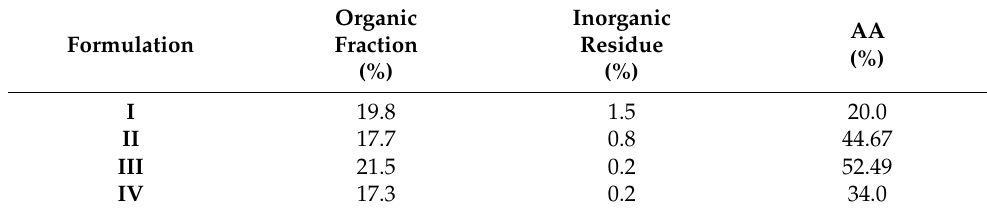
Table 3. Results highlighting organic fraction and inorganic residue at 600 °C from Thermogravimetric Analysis (TGA) and antioxidant activity electrochemical (AA%). Standard uncertainty of TGA measurements was 0.5% w, while the SD for the electrochemical measurements was 4.5% ( n = 3).